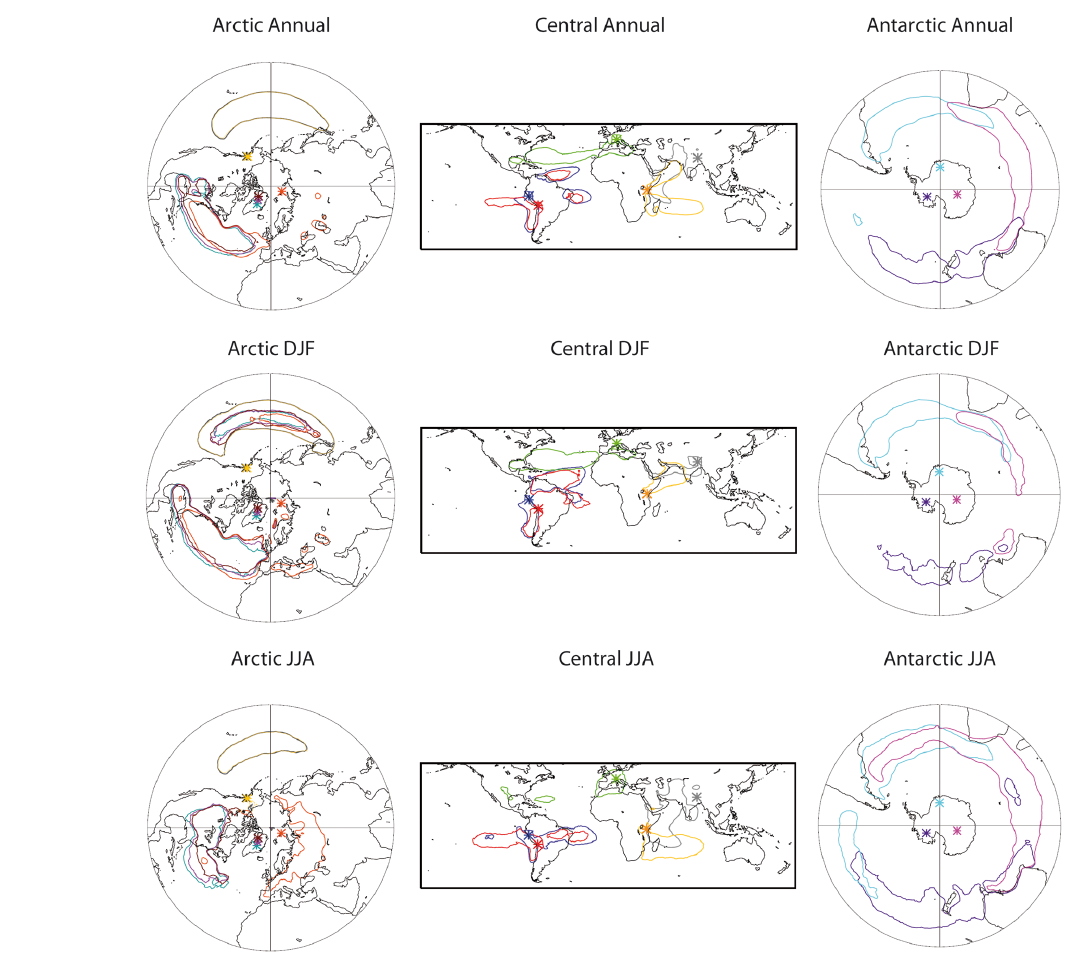
Figure 3. Moisture sources for the ice-core sites located in the Arctic (left-hand column), Central (central column), and Antarctic (right-hand column) domains for the annual (top line), DJF (central line), and JJA (bottom line) temporal means. The contour lines represent the 95th percentile of the positive E − P values in the annual mean for each ice-core Lagrangian analysis. The asterisks indicate the location of the ice-core sites investigated, represented by different colours. The colours for the Arctic Domain are Logan (grey), Bona–Churchill (yellow), Windy Dome (orange), GISP2 (blue), NEEM (brown), and NGRIP (violet); for the Central Domain they are Huascarán (dark blue), Sajama (red), Grenzgletscher (green), Kilimanjaro (yellow), and Everest (grey); for the Antarctic Domain they are Byrd (purple), DML (clear blue), and Vostok